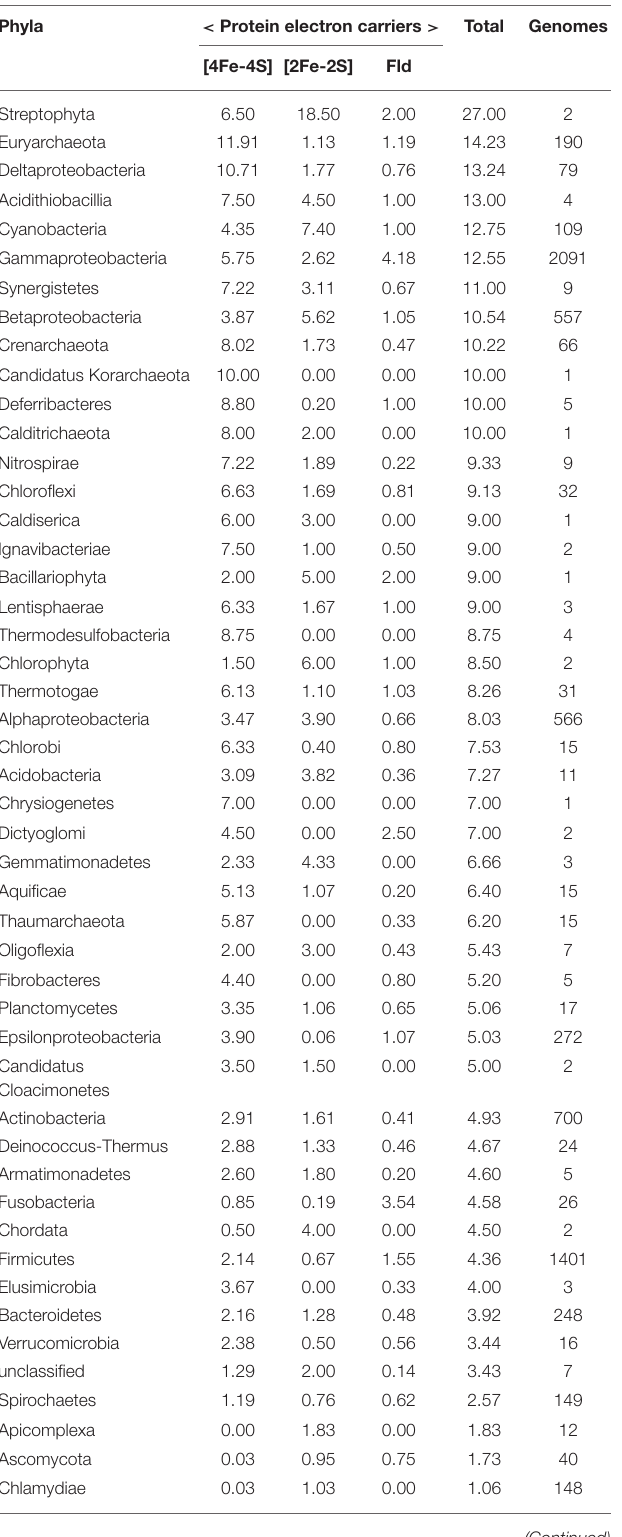
TABLE 1 | The average PEC gene counts for each phylum is displayed, including the number of [4Fe-4S] Fd, [2Fe-2S] Fd, and Fld genes, as well as the sum of all three